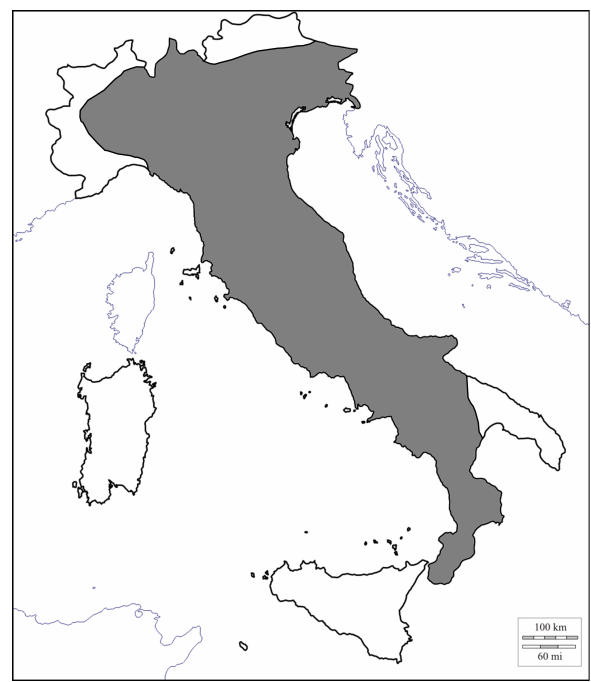
Figure 12. Distribution map of Arvicola italicus (redrawn from Cagnin